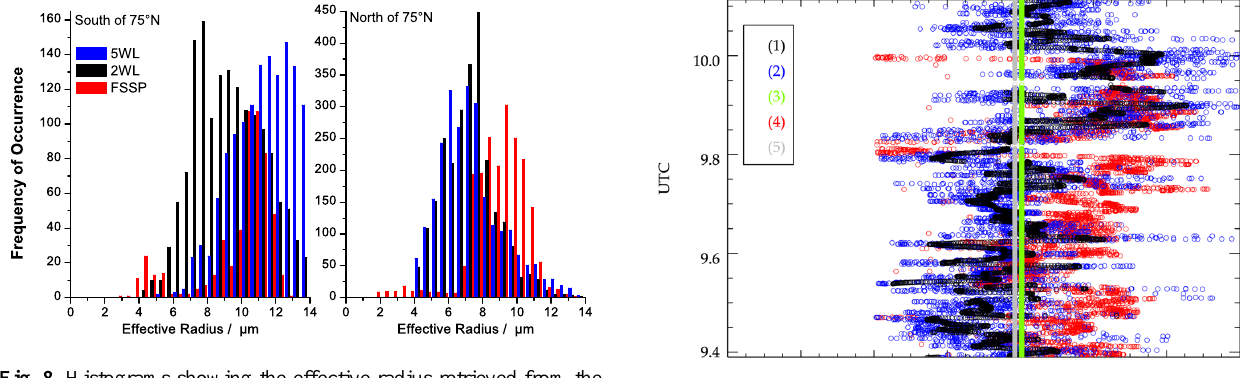
Fig. 8. Histograms showing the effective radius retrieved from the SMART-Albedometer radiance by 5WL (blue) and 2WL (black) and as observed by the FSSP (red) at the same latitude, but one hour later. Left: for the flight section south of 75 ◦ N. Right: north of 75 ◦ N.